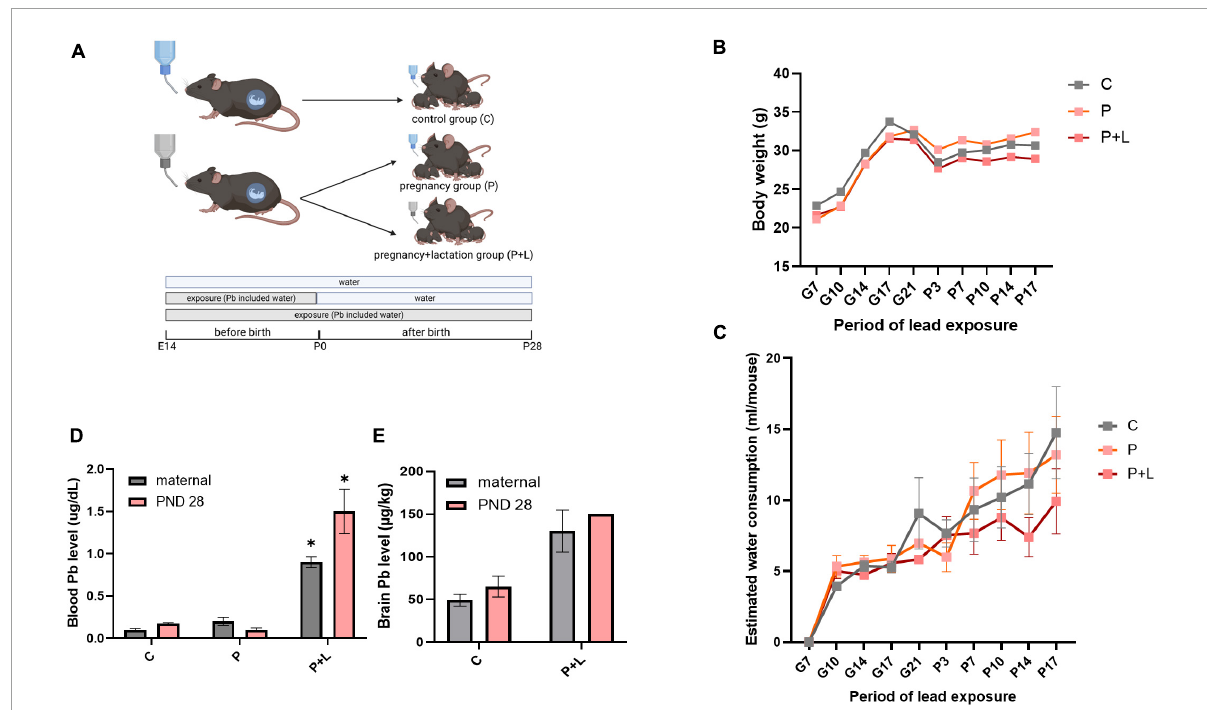
FIGURE1 Modeling of maternal lead exposure model and validation of lead exposure model in cerebellum. (A) Scheme of designing Lead exposed mouse model. Each groups were sacrificed at PND28. Offspring were labeled by lead-exposure period. Groups were labeled as Pregnancy group (P), Pregnancy+lactation group (P+L). (B) Body weight of lead exposed mouse during pregnancy. (C) Estimated water consumption during pregnancy (D) Blood lead level of mother and offspring mouse. Data were analyzed with Two-way ANOVA, expressed by mean ± SEM. ∗ p < 0.05. (E) Brain lead level of mother and offspring mouse. Data were analyzed with Two-way ANOVA, expressed by mean ±